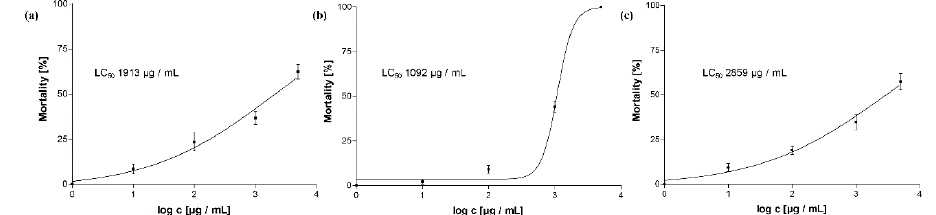
Figure 5. Dose-response curves of ( a ) the crude acetone-water (7:3) extract, ( b ) the ethyl actetate partition, and ( c ) the aqueous partition. Corresponding LC 50 values as obtained by nonlinear regression are given within the respective curve.